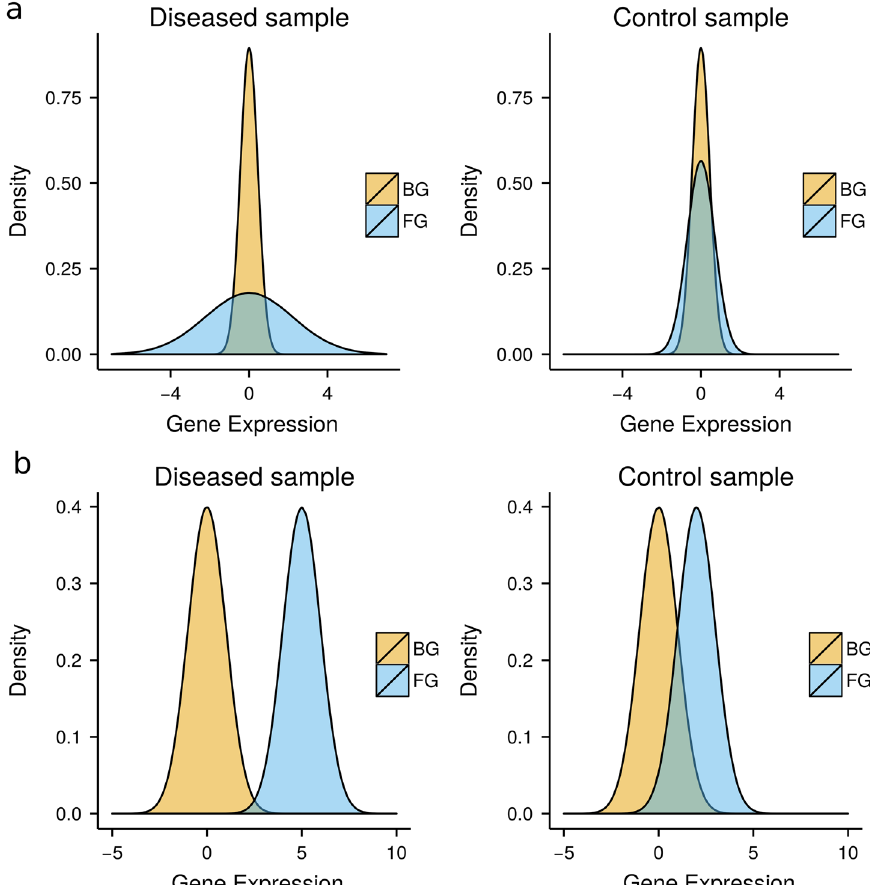
Fig. 4 Illustration of the used models for FG and BG expression distributions generated for cases and control samples: VV in ( a ) and VM in ( b